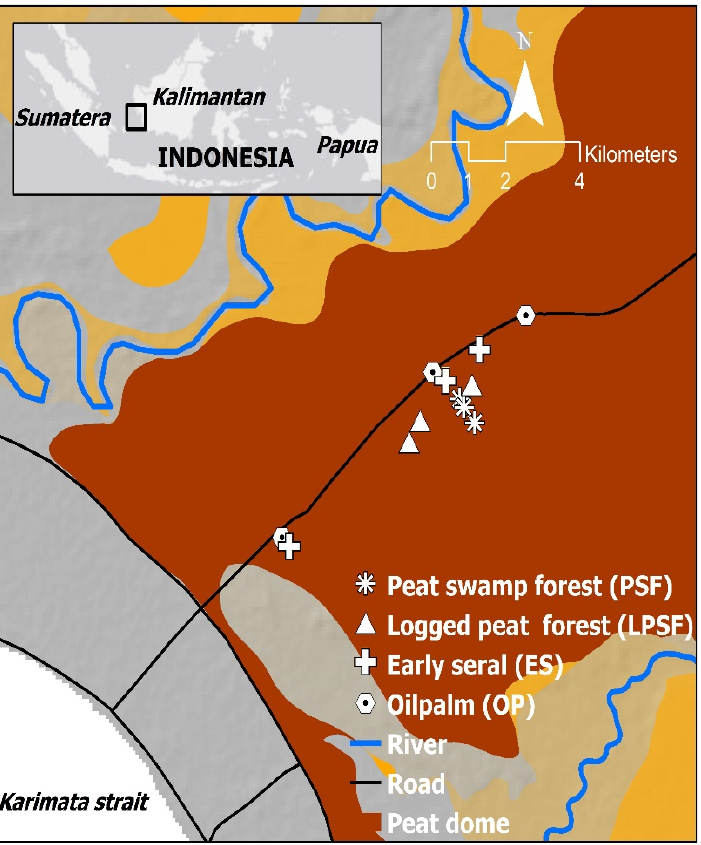
Figure 1. Study sites (white markers) within a deep peat dome near Ketapang, West Kalimantan, Indonesia. Roads (black line) cross-cutting the deep peat dome (dark brown). The peat area was delineated by [30] to represent a dome-shaped peatland between Pawan River on the north and Pesaguhan River on the south. Grey areas represent the non-peat areas. Adapted by permission from [Springer Nature Customer Service Centre GmbH]: [Springer Nature] [Mitigation & Adaptation Strategies for Global Change] (Land cover changes reduce net primary production in tropical coastal peatlands of West Kalimantan, Indonesia, Imam Basuki et al.), [COPYRIGHT] (2018) [23]. In addition to the forests, three early seral dominated by grasses and ferns (ES) and three smallholder oil palm estates (OP) were sampled. The OP estates were in close proximity to the other land cover types. The early seral sites had been logged in the past.